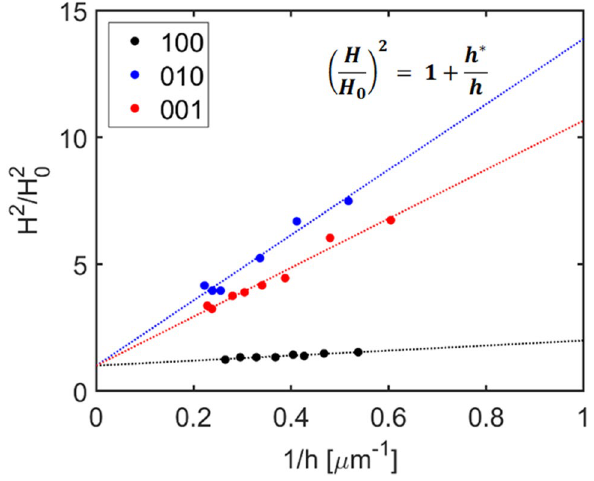
Fig. 9 Comparisons of Nix Gao fitting of hardness data for 3 planes